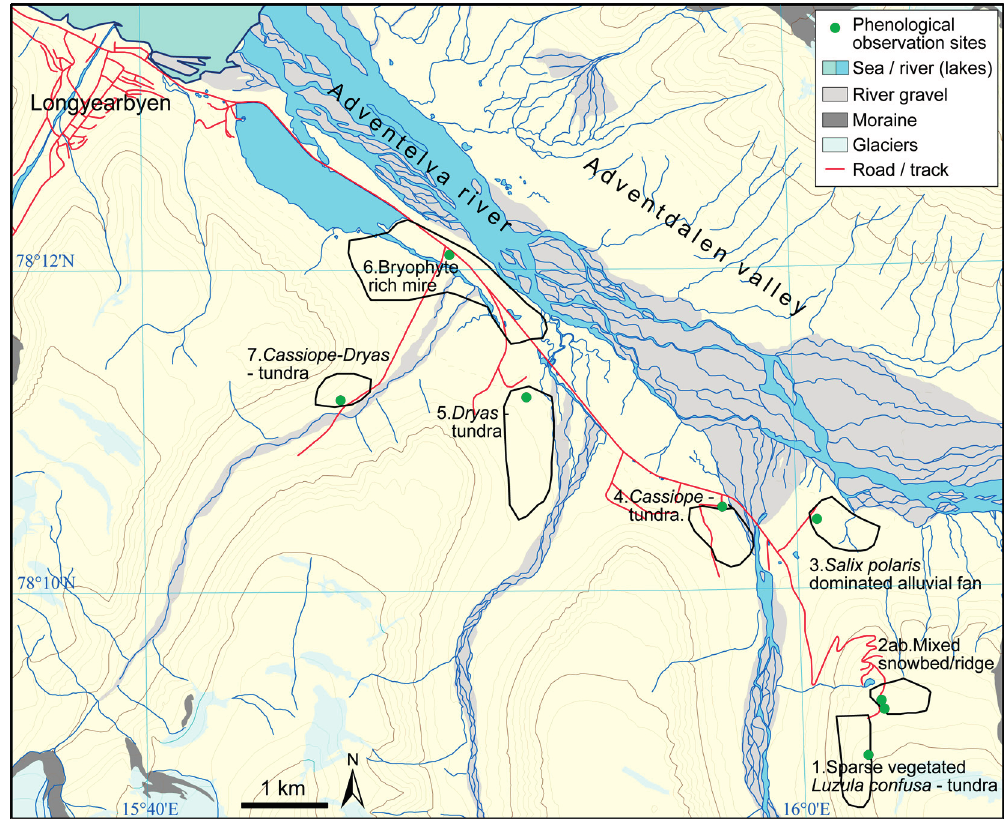
Figure 2. Phenological observation sites in the Adventdalen valley. The Svalbard administration center Longyearbyen is situated in the northwestern corner of the map. The polygons surrounding the observation sites represent the dominating vegetation type, and the MODIS data are calculated for the polygons to compare with the field data. Contour interval is 50 m, with supplementary interval on 25 m, and where 250 m, 500 m and 750 m are shown in bold.